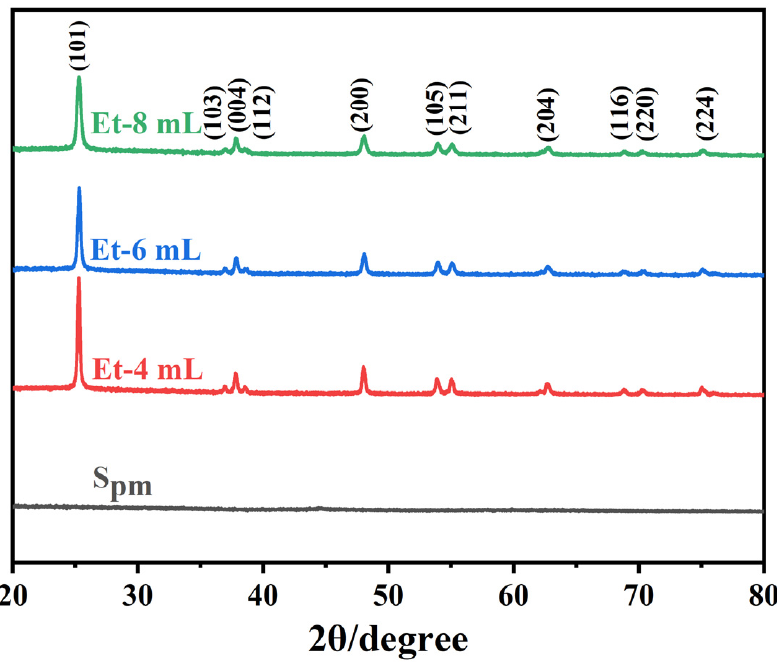
Figure 2. XRD patterns of precursor (S pm ) and crystalline products (Et-4 mL, Et-6 mL and Et-8 mL). Table 1. The preparation parameters (EtOH/H 2 O), crystallite sizes, particle aspect ratios (PAR) and specific surface areas (SSA) of precursor (S pm ) and crystalline products (Et-4 mL, Et-6 mL and Et-8 mL).